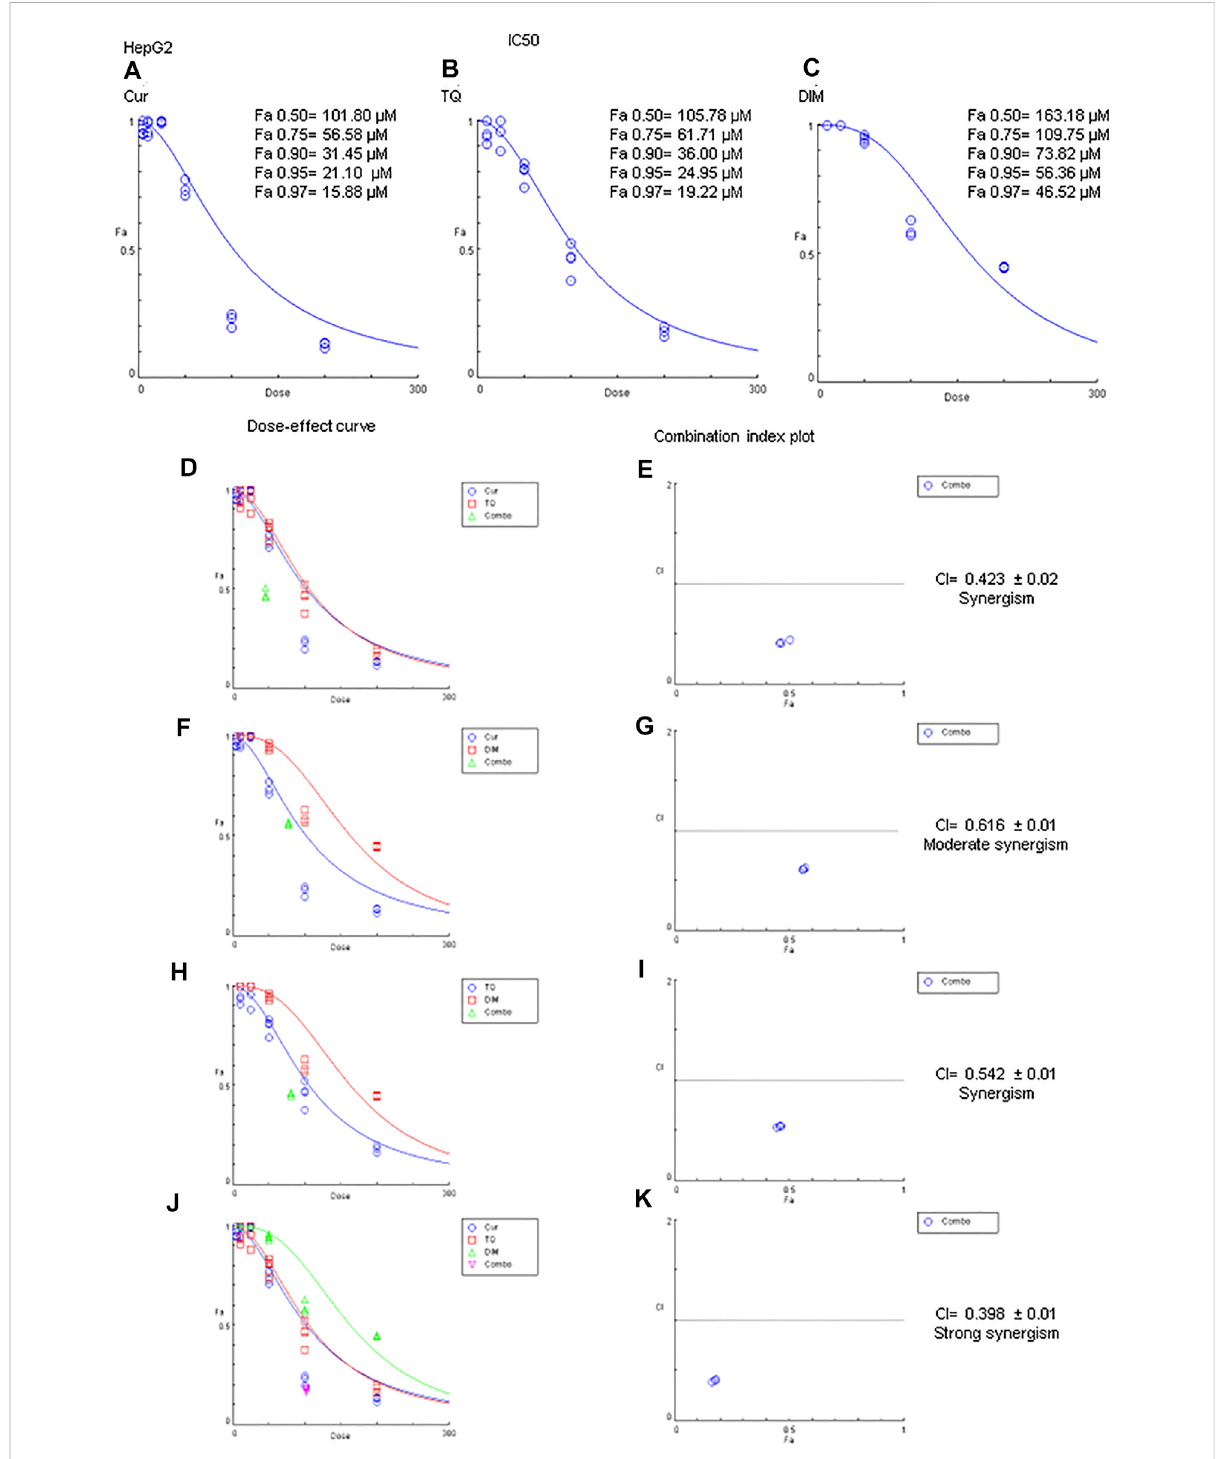
FIGURE 5 Fa values and combination index of curcumin (Cur), thymoquinone (TQ), and 3,3 ′ -diindolylmethane (DIM) against HepG2. (A) Fa values of Cur against HepG2. (B) Fa values of TQ against HepG2. (C) Fa values of DIM against HepG2. (D) Dose-effect curve of Fa 95 of Cur (12.71 µM) and TQ (24.95 µM). (E) CombinationindexplotofFa95ofCurandTQ. (F) Dose-effectcurveofFa95ofCur(21.10 µM)andDIM(56.36 µM). (G) Combination indexplot ofFa 95of Curand DIM. (H) Dose-effectcurve ofFa 95of TQ(24.95 µM) andDIM (56.36 µM). (H) Combination index plotof Fa95 of TQandDIM. (J) Dose-effectcurveofFa95ofCur(21.10 µM),TQ(24.95 µM),andDIM(56.36 µM). (K) CombinationindexplotofFa95ofCur,TQ,and DIM. The CI values represent the mean of four experiments. CI > 1.3: antagonism; CI (1.1 – 1.3): moderate antagonism; CI (0.9 – 1.1): additive effect; CI (0.8 – 0.9): slight synergism; CI (0.6 – 0.8): moderate synergism; CI (0.4 – 0.6): synergism; CI (0.2 – 0.4): strong